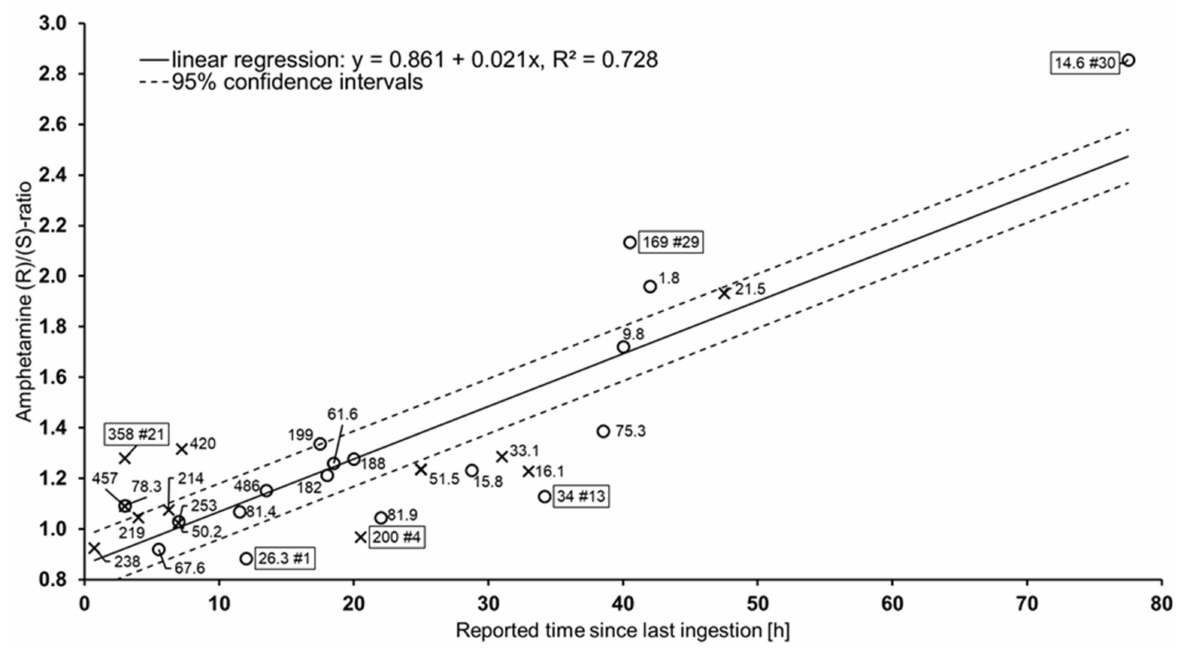
Figure 6. Plot of the determined amphetamine (R)/(S) ratios versus the reported time since last ingestion according to the patients’ statements (n = 30). Cases with reported binge consumption (further consumption of amphetamine within the last 24 h) are marked as crosses (x); all other cases are presented as circles (o). Labels show the total (racemic) amphetamine concentration of each patient in ng/mL. For some patients, the case number is also given with a number sign (#). Linear regression (solid line) was done using the method of least squares. Broken lines show 95% confidence